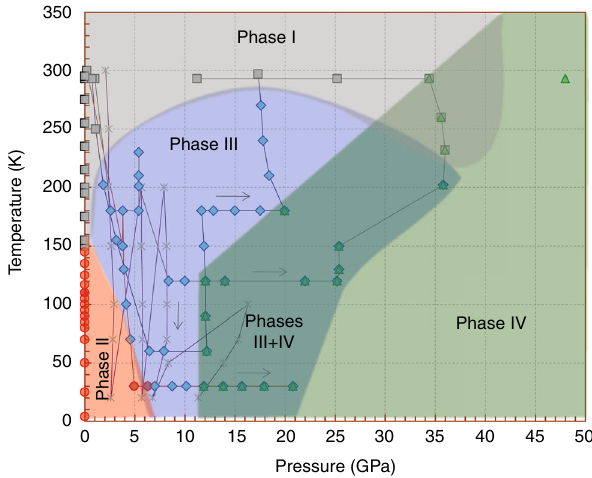
Fig. 2 High-pressure low-temperature phase diagram of Fe 4 O 5 . The diagram is based on the single crystal X-ray diffraction experiments. Experimental points on the diagram corresponding to different phases are shown in different symbols. The shaded areas show the proposed stability regions of the phases. The lines and arrows show the directions of the pressure and temperature variation during the experiments. Since the basic structural re fl ections of Fe 4 O 5 -I and Fe 4 O 5 -III structures are identical (Fig. 3), the region of their co-existence could not be properly delineated. One cannot rule out that the region of Fe 4 O 5 -III in the phase diagram might be a superposition of stability ranges of Fe 4 O 5 -III-a and Fe 4 O 5 -III-b